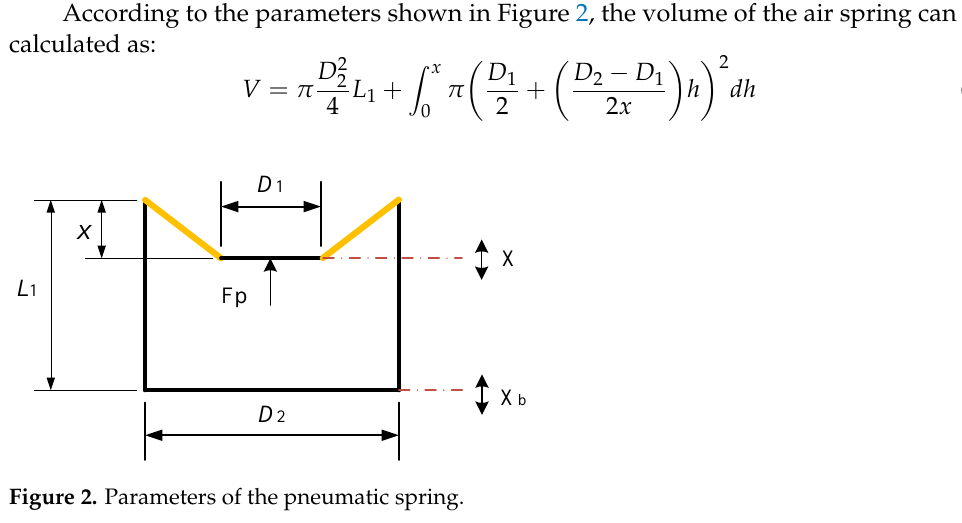
Figure 2. Parameters of the pneumatic spring.